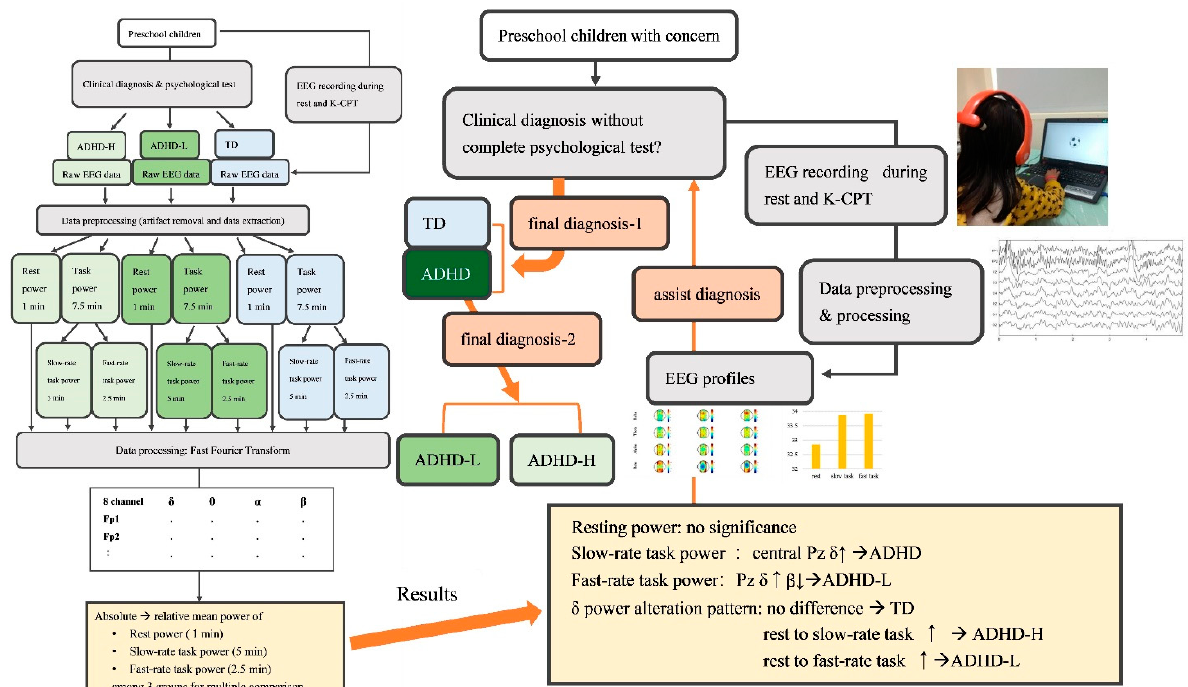
Figure 8. The concept of clinical application.